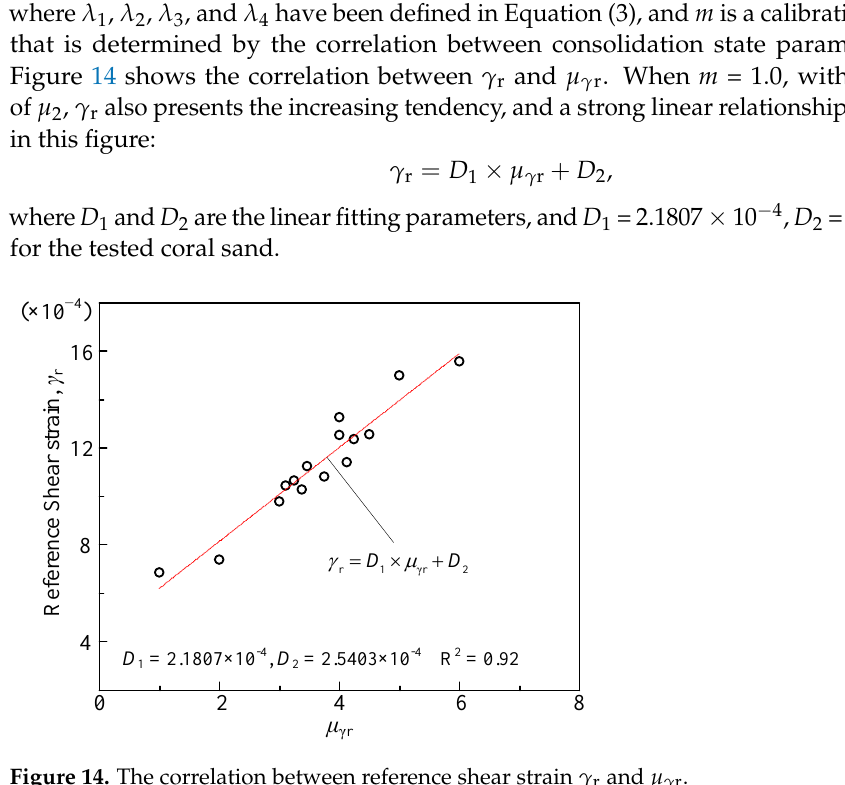
Figure 14. The correlation between reference shear strain γ r and μ γr .